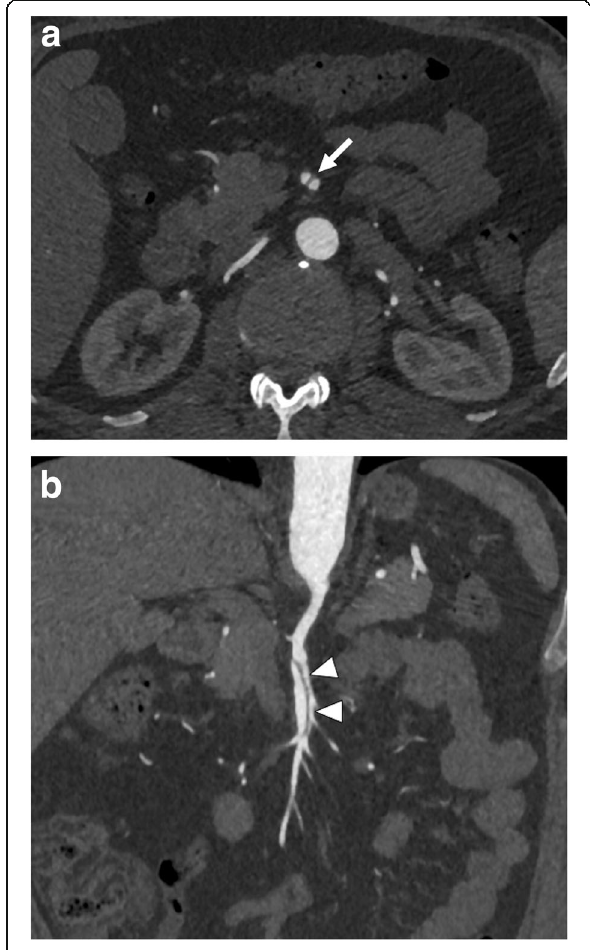
Fig. 22 SMA dissection. A 59-year-old male with known COPD presented with severe diffuse abdominal pain. a Axial plane arterial phase CT image shows a linear hypodense thin structure suggestive of an intimal flap within the SMA lumen (arrow). b Coronally reformatted post-contrast arterial phase CT image demonstrates long segment dissection (arrowheads) within the SMA with no extension into the abdominal aorta. The findings were found to be suggestive for isolated SMA